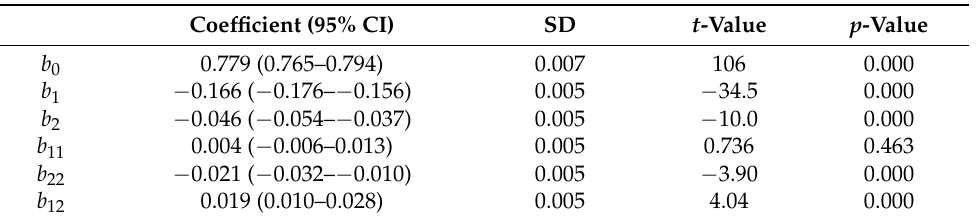
Accurate prediction of initial meropenem concentrations within the studied range was also obtained with the artificial neural network (ANN) model, with a mean RMSE of 3.55% and mean R² of 0.945. The results suggest that the ANN outperformed the polyno- mial model over the studied concentration range. The evaluation metrics are summarized in Table 2. Figure 3 illustrates that the neural network was able to better capture the non- linearity of the degradation profile, whereas the polynomial model was restricted to a quadratic approximation.